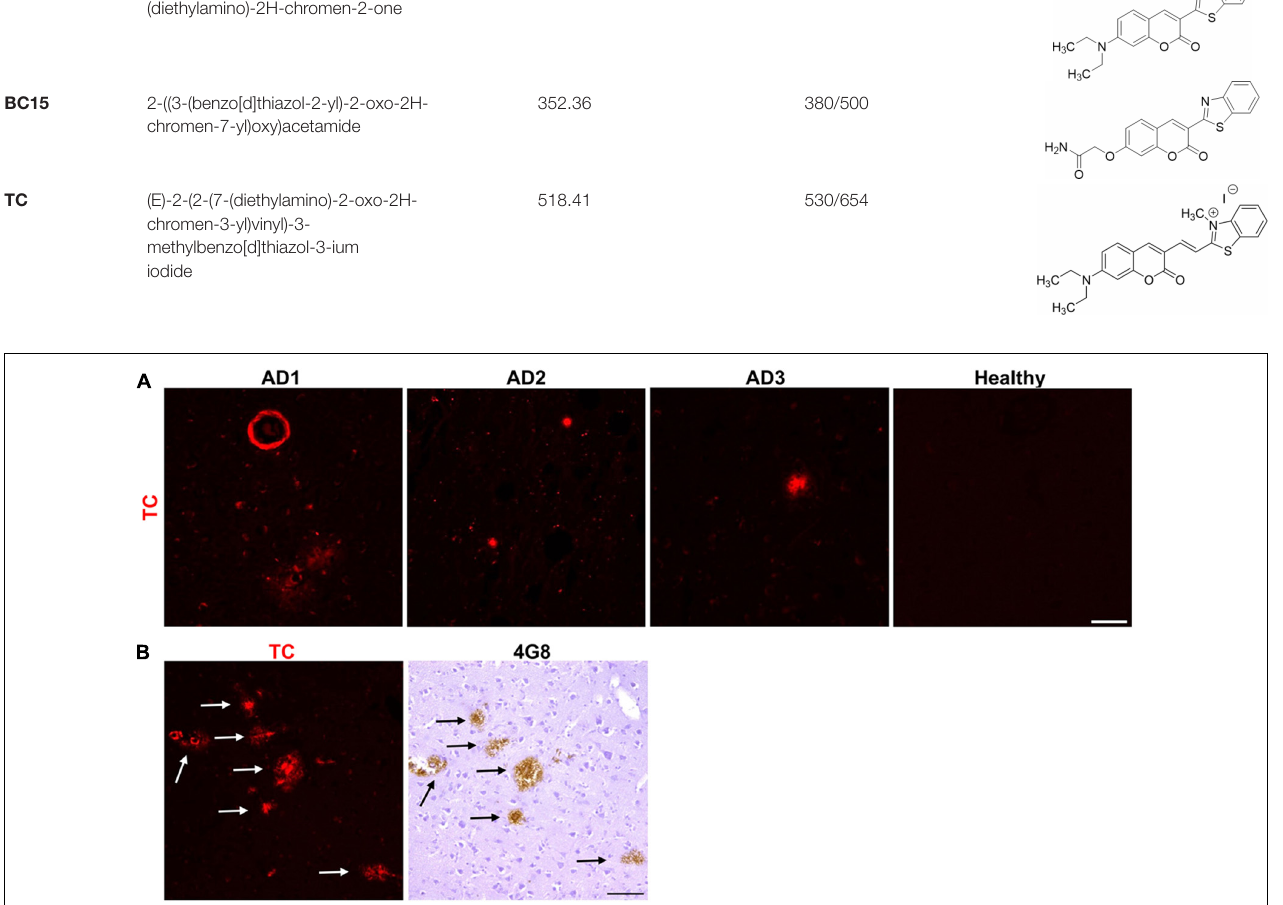
FIGURE 1 | Neuropathological staining of A β plaques with the fluorescent probe TC. (A) TC (50 µ M) intensely stained A β plaques, both parenchymal, and vascular, in 10 µ m sections from frontal cortex of three AD patients, while there was no apparent staining in age-matched healthy brain section. Scale bar 50 µ m. (B) TC-stained A β plaques in AD brain sections were confirmed by immunohistochemical staining of mirror image sections with 4G8. The image of the dye-staining was flipped horizontally to match the same location of the immunohistochemically-probed section. Arrows in immunohistochemically-stained slides correspond to the plaques in the mirror images stained by the dye. Scale bar 50 µ